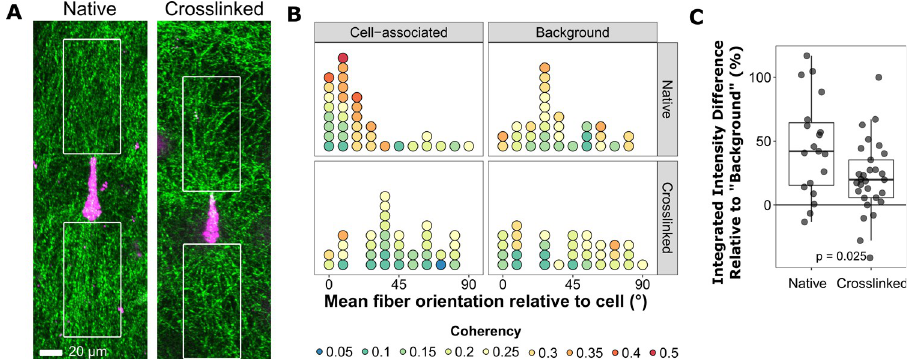
Fig 3. Crosslinking decreases the alignment of fibers associated with individual cells migrating out of spheroids. DiI-stained HT-1080 cells that had invaded from spheroids into native and crosslinked matrices overnight (~12 h) were imaged along with the surrounding fibers to determine the effect of matrix crosslinking on individual cells’ ability to align fibers. We selected cells that were mostly bipolar, mostly parallel to the surface, and not near other cells. ( A ) Representative images of cells (magenta) and collagen matrix (green; reflectance imaging) from native and crosslinked matrices. The images are maximum intensity z-projections of seven slices. Fiber orientation and density were measured within 50x100 μ m regions (white boxes) at either end of each cell. Measurements from the two regions were averaged to produce one measurement per cell. ( B ) Plot of predominant orientation in cell-associated regions (“Cell- Associated”) or in random non-cell areas of the same images (“Background”) in crosslinked or native matrices (n = 31 background/native, 32 background/crosslinked, 35 for both cell-associated sets). Each circle represents the measurement from a single cell (average of front/back regions) or non-cell associated area (average of two regions from the same image). Orientations are relative to the long-axis of the cell (parallel to the cell = 0˚). Color indicates the coherency—the uniformity of orientations within the region (scale of 0 to 1.0; 1.0 = perfect uniformity). Only the distribution of orientations from the native, cell-associated samples were significantly different from a random distribution (Rao Spacing Test, p < 0.001; all others p > 0.05). The coherency of cell-associated native fibers was significantly different from cell-associated crosslinked (p < 0.001), but not background native (p = 0.25) (Welch’s t- Test; multiple comparisons adjusted using Benjamini-Hochberg). There was no significant difference between crosslinked cell-associated and background fibers (p = 0.25). ( C ) “Density” was measured as the percent difference in the integrated intensity of cell-associated and “background” regions from the same image. Cell-associated regions in native matrices were significantly “denser” than in crosslinked matrices (p = 0.025; two-tailed t-Test; n = 21 native, 28 crosslinked). Data in (B) and (C) come from five independent